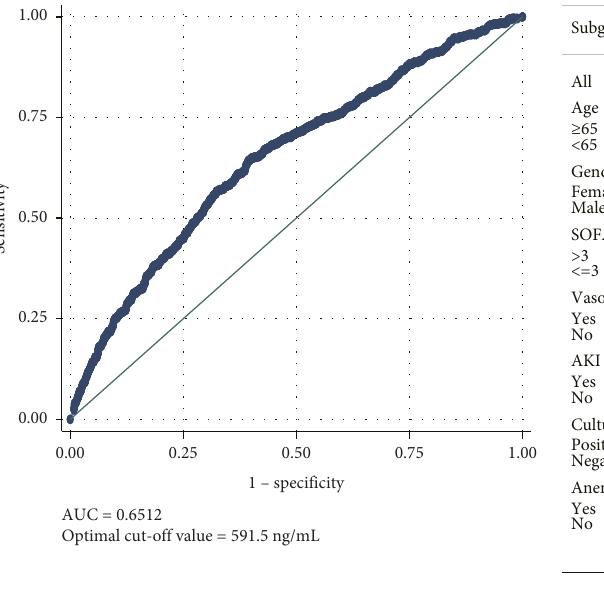
AUC = 0.6512 Optimal cut-off value = 591.5